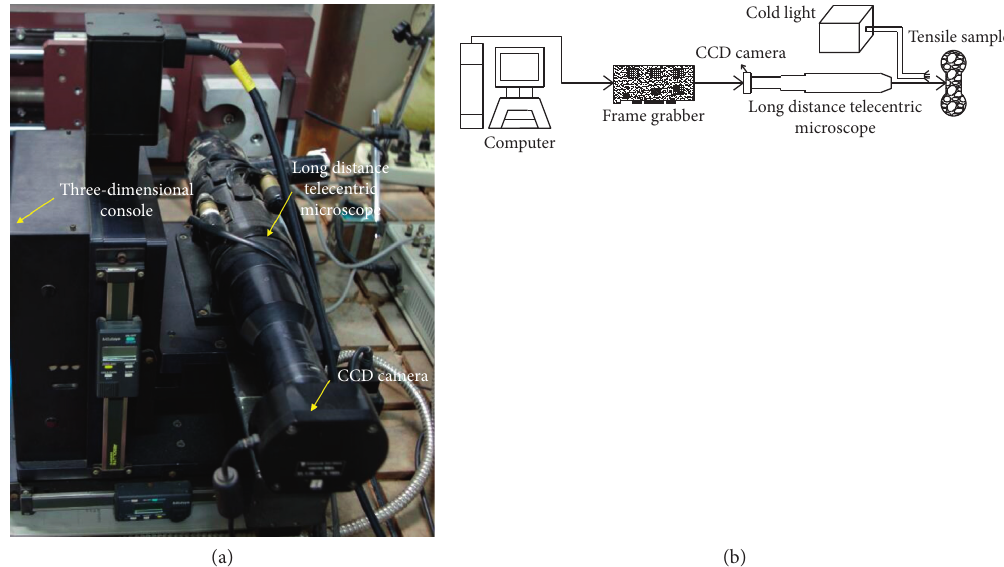
Figure 2: The image acquisition device: (a) microscope and three-dimensional console; (b) transmission path of image signal.